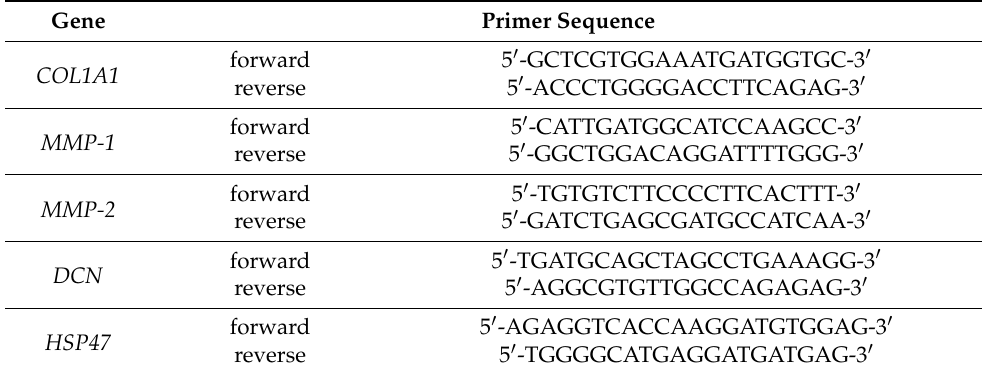
Table 1. Sequences of primer used in the quantitative Real-Time PCR.